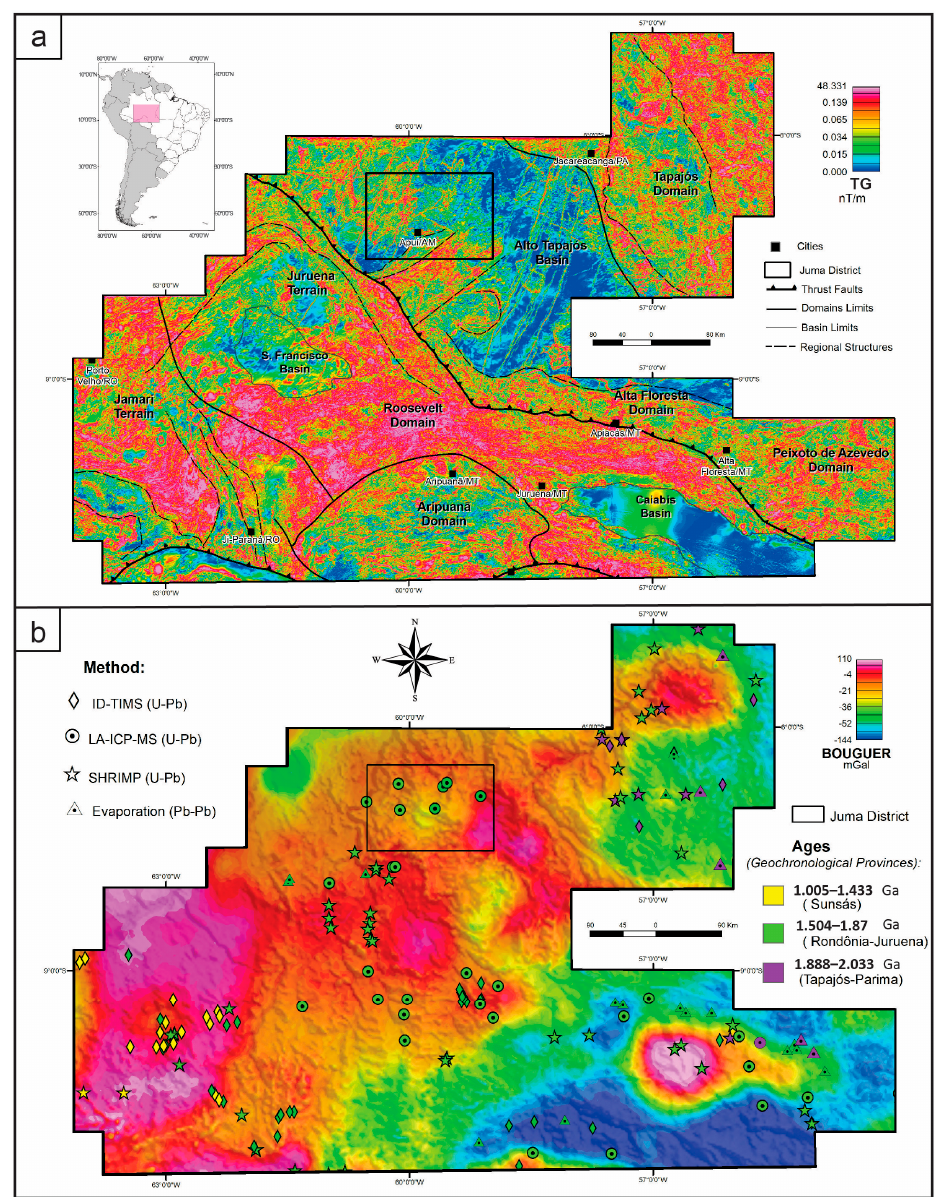
Figure 1. Airborne magnetic and satellite gravimetric maps for the Southern Amazon Craton; ( a ) Major structures and domains superimposed on the total gradient (TG) of total magnetic intensity (TMI); ( b ) geochronological data compiled from the Geological Survey of Brazil (GSB) and [27] on the Bouguer anomaly map (WGM2012) [30].